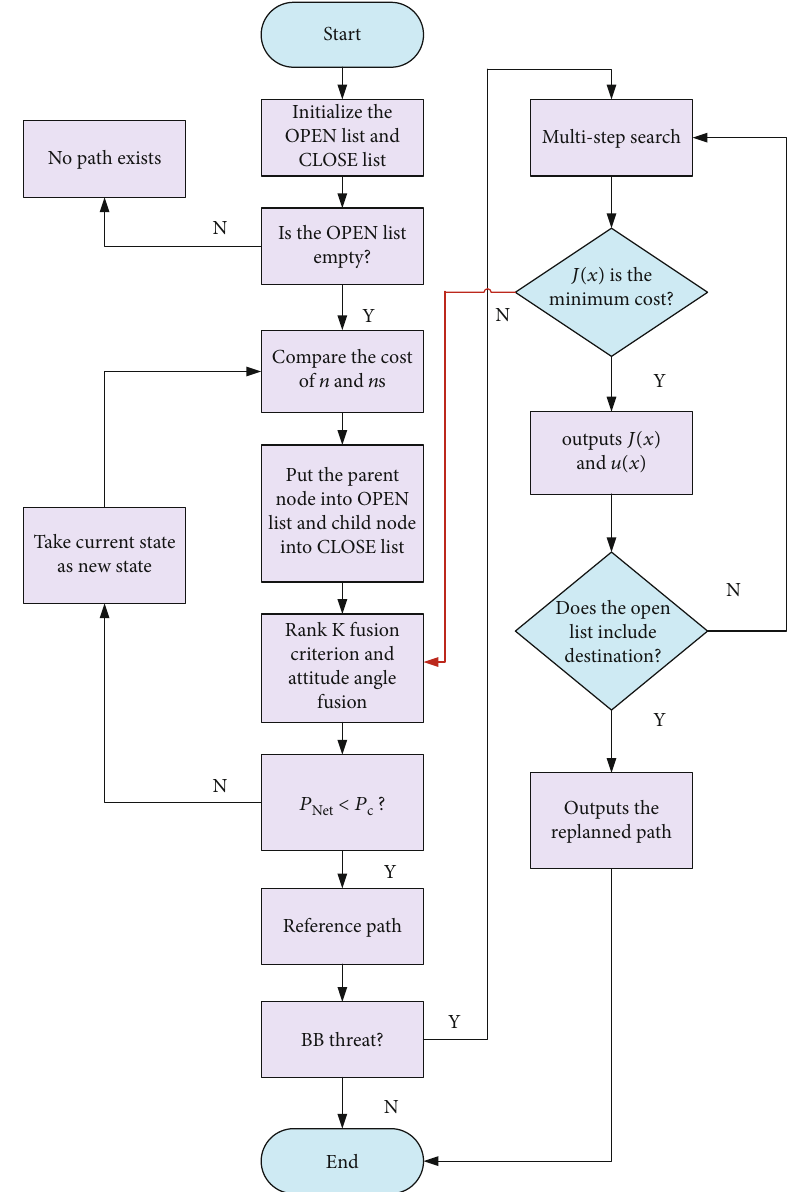
Figure 3: The fl ow chart of the improved A-Star